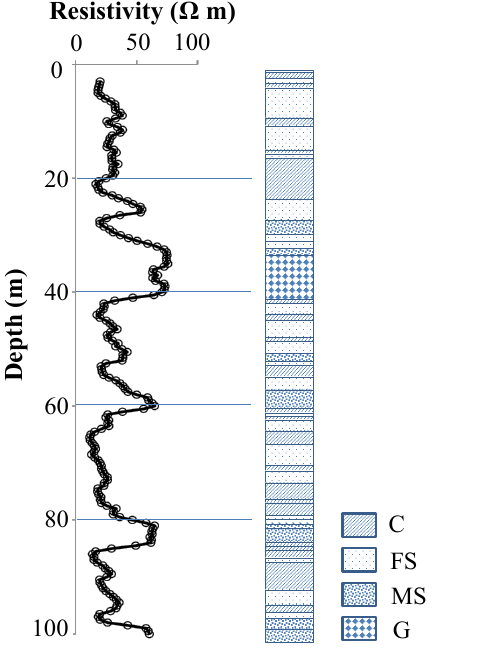
Figure 3. Typical depth behaviors of resistivity and corresponding stratigraphy in the eastern part of zone 2.